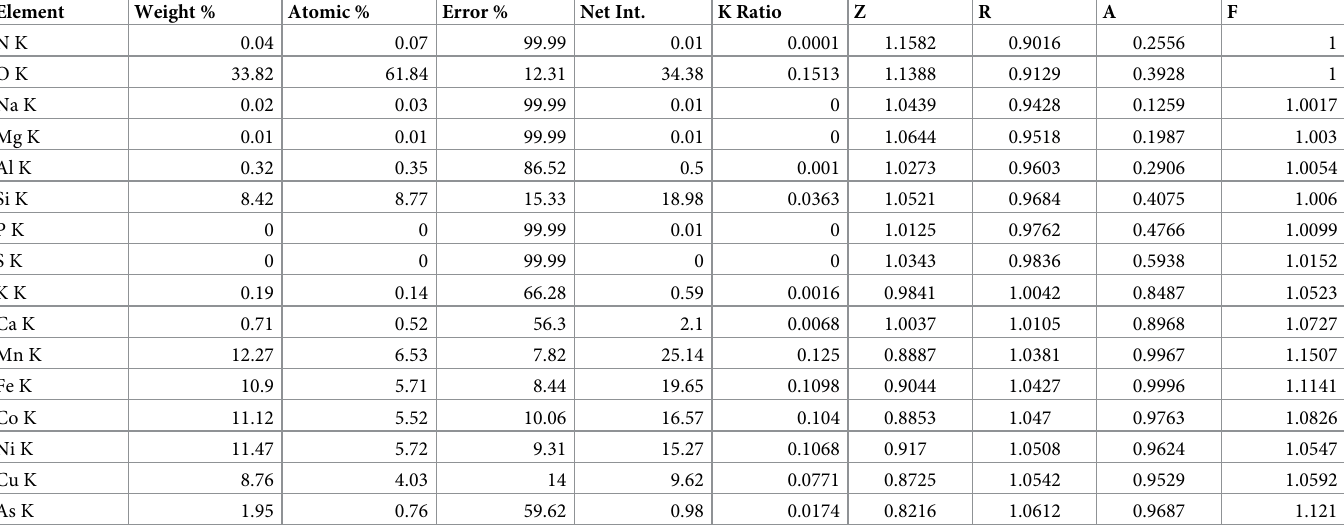
Table 2. List of the elements value generated by FESEM-EDS analysis in Yak dung sample collected from winter season. Element Weight % Atomic